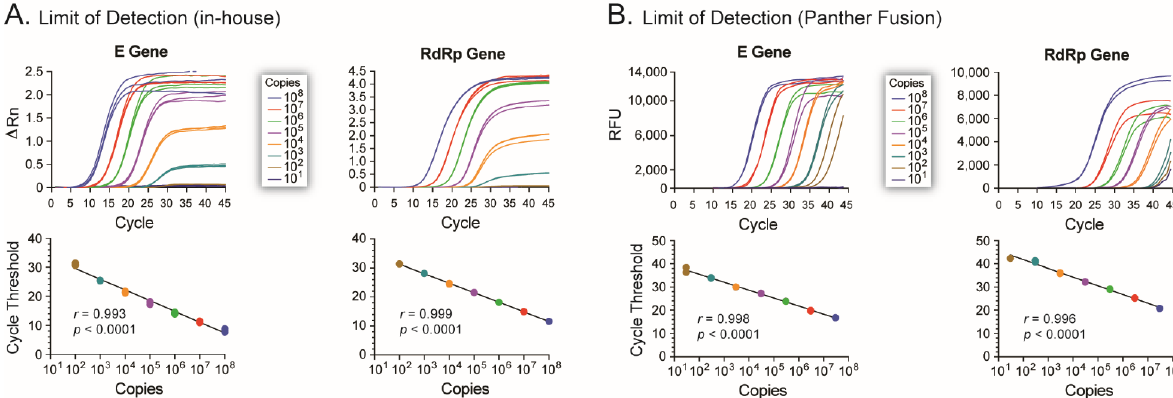
Figure 2. Analytical sensitivity of the RT-qPCR COVID-19 diagnostic test. The ability of the in-house ( A ) and Panther Fusion ® System ( B ) RT-qPCR assays to detect SARS-CoV-2 was evaluated using serial dilutions of RNA in vitro transcribed from the RdRp and E plasmid controls. Real-time PCR and calibration curves are indicated for both SARS-CoV-2 genes in both versions of the RT-qPCR assay. Rn, magnitude of signal (Rn value of the reaction with template minus the Rn value of the unreacted sample, without template); Ct, cycle threshold; Copies, number of in vitro-transcribed SARS-CoV-2 RNA copies; RFU, relative fluorescence units. Linear dynamics, regression ( r ) and two-tailed P ( p ) values are